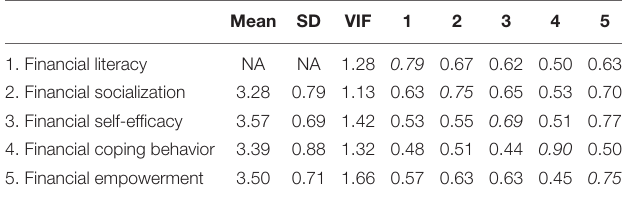
TABLE 2 | Mean, standard deviations, correlations, and discriminant validity results.